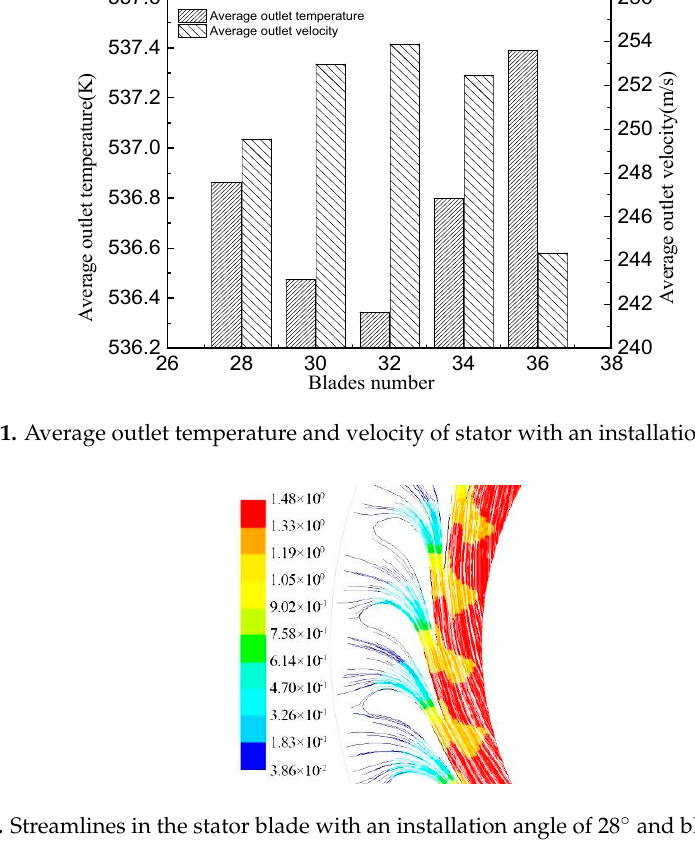
Table 3. Geometric parameters of stator blades. Working Fluids